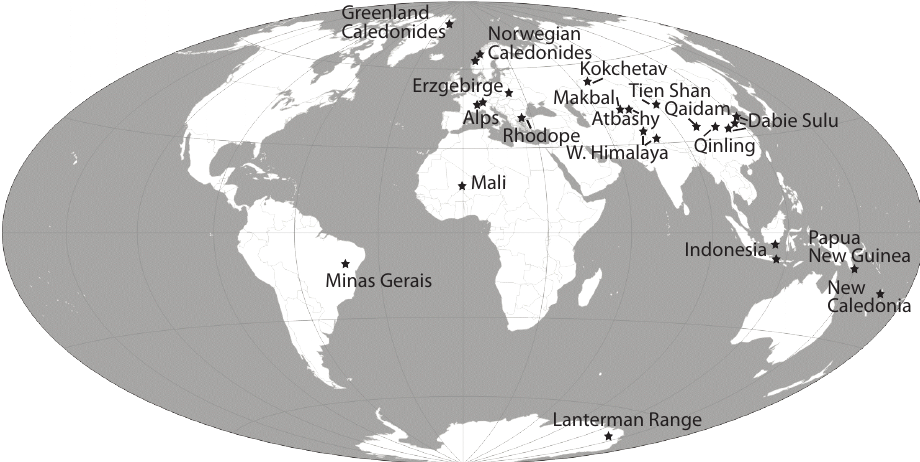
Fig. 1. Map showing the major well-described coesite-bearing, continental crustal, UHP terranes (but not the locations of UHP peridotite bodies). Modified from Chopin (2003), Liou et al. (2004) and Tsujimori et al.